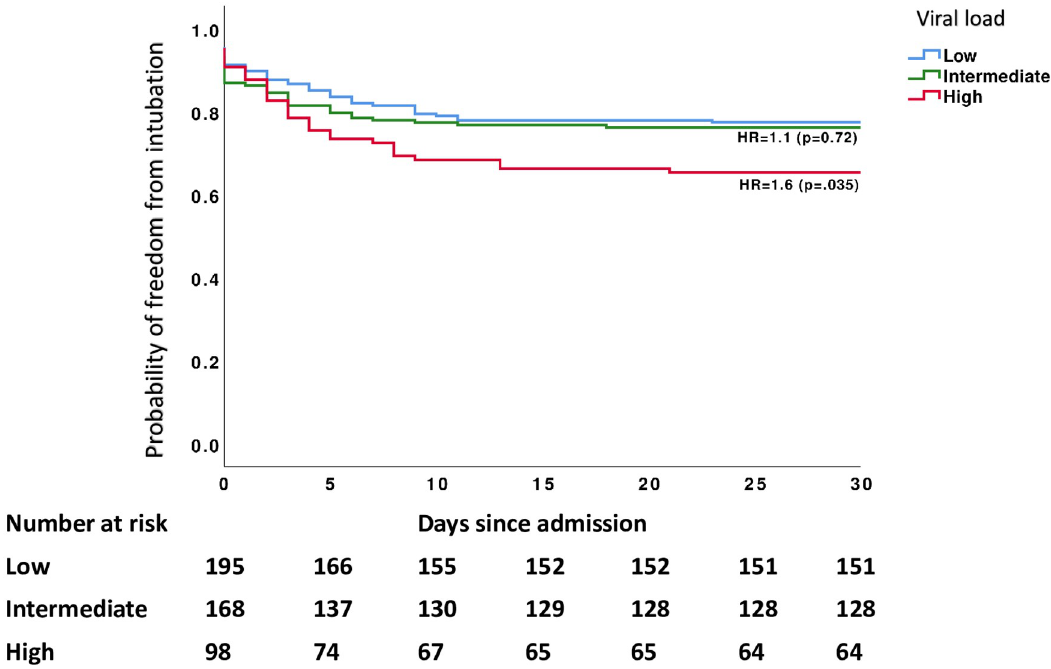
Fig 4. Probability of freedom from intubation in hospitalized patients with SARS-CoV-2 infection stratified by initial viral load category.